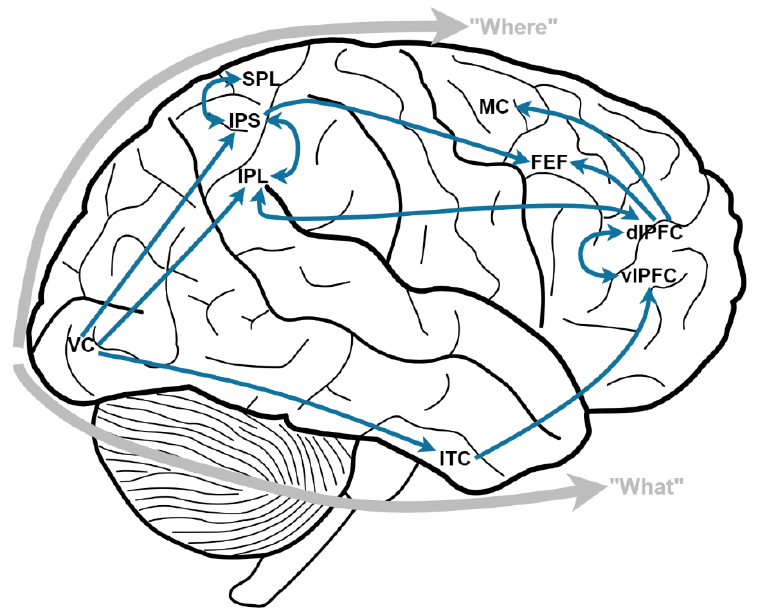
Figure 1. Identification of brain areas associated with the dorsal and ventral visual pathways, re- spectively.